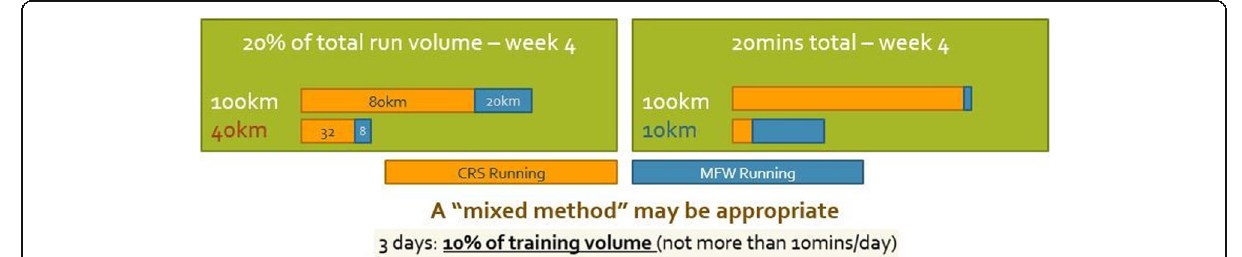
Fig. 3 An example of the two common prescription methods for MFW exposure (distance vs. time). On the left, it is apparent that athletes running